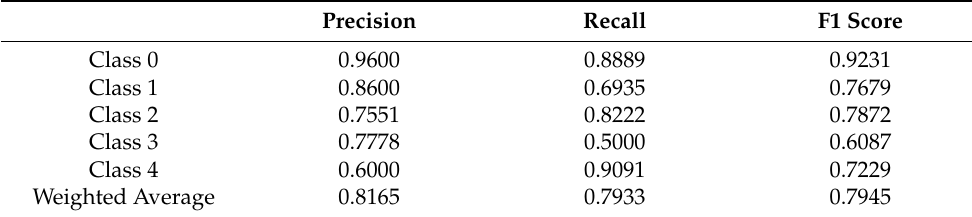
Table 2. Performance metrics for Mauritian data classified by ResNet50.